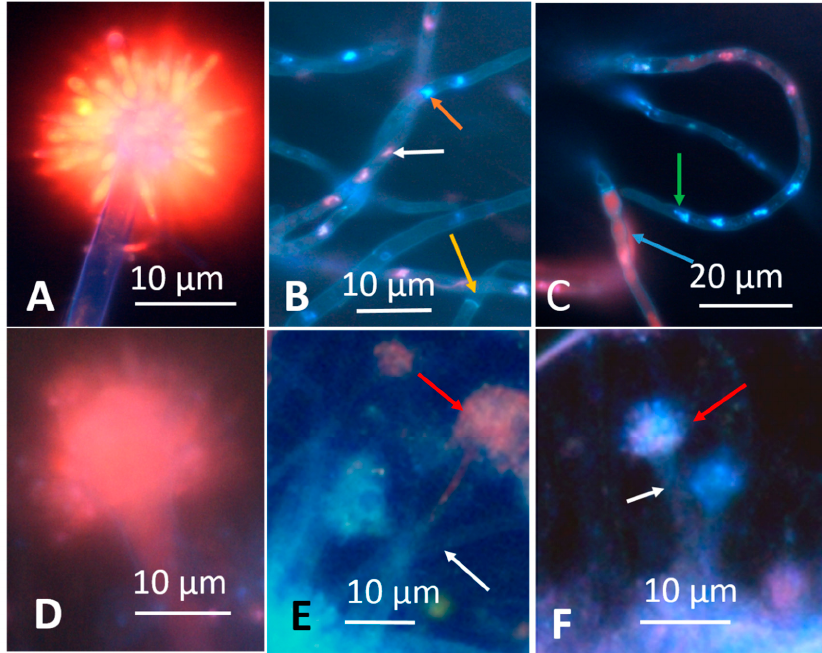
Figure 2. Micrographs showing young and old conidiophores and hyphae of Aspergillus versicolor SL/3 grown on malt extract agar and stained with the nucleic acid stain Hoechst 33342 + propidium iodide. Hoechst 33342 crosses intact and damaged plasma membranes, staining the DNA in nuclei and mitochondria in both live and dead cells blue. Propidium iodide crosses only plasma membranes with lost or exceptional integrity, and stains intracellular DNA and RNA red. The upper row ( A – C ) is pictured from a young (1 week), actively growing culture, whereas the lower row ( D – F ) shows an old (8 weeks), dehydrated, inactive culture. ( A ) conidiophore emitting bright red-yellow fluorescence in the phialides and metulae, the stipe emitting violet fluorescence; ( B ) hyphae containing blue and red fluorescing nuclei (orange and white arrows) and a septum (yellow arrow); ( C ) hyphae containing irregular dividing nuclei (green arrow) and a hyphae with red fluorescence emitting cytoplasm (blue arrow); ( D ) conidiophore emitting uniform weak fluorescence in the phialides, metulae and stipe; ( E ) non-fluorescent hyphae (white arrow) and a weakly red-fluorescing conidiophore (red arrow); ( F ) nonfluorescent stipe (white arrow) and a violet fluorescing conidiophore (red